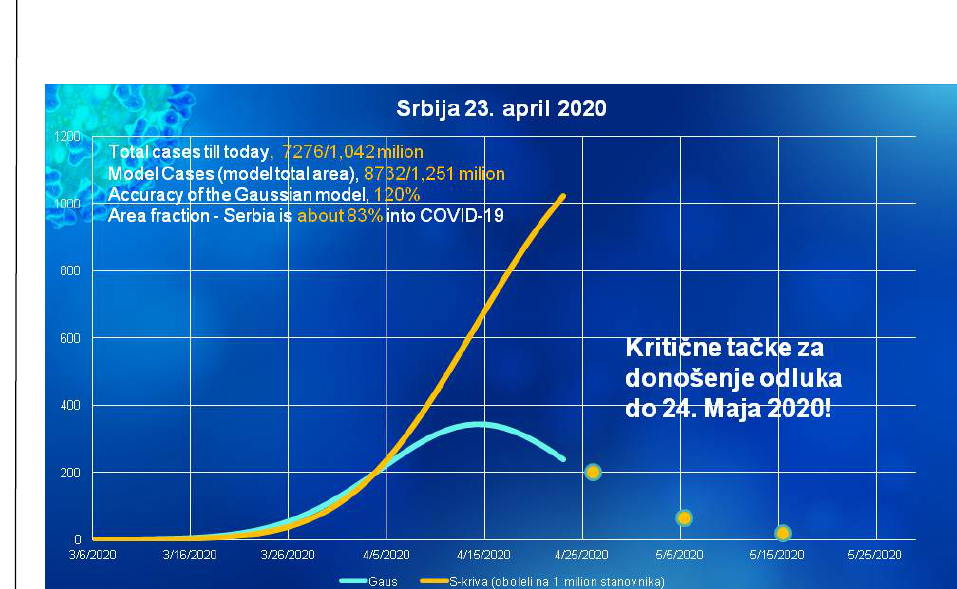
Figure 6 – Truncated Gaussian curve for Serbia, on April 23, 2020. At that time, the forecasted end of the epidemic was May 24, 2020. The dots represent the dates when critical decisions should be